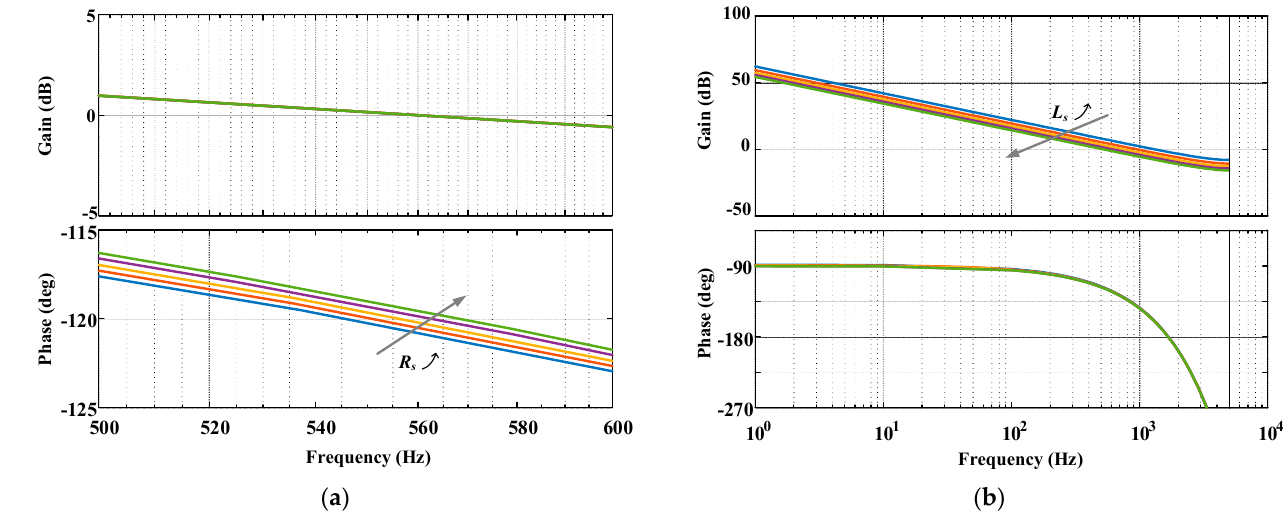
Figure 16. The bode diagram of parameters’ mismatch: ( a ) resistance changes from 0.5 R s to 3 R s ; ( b ) inductance changes from 0.5 L s to 2 L s .